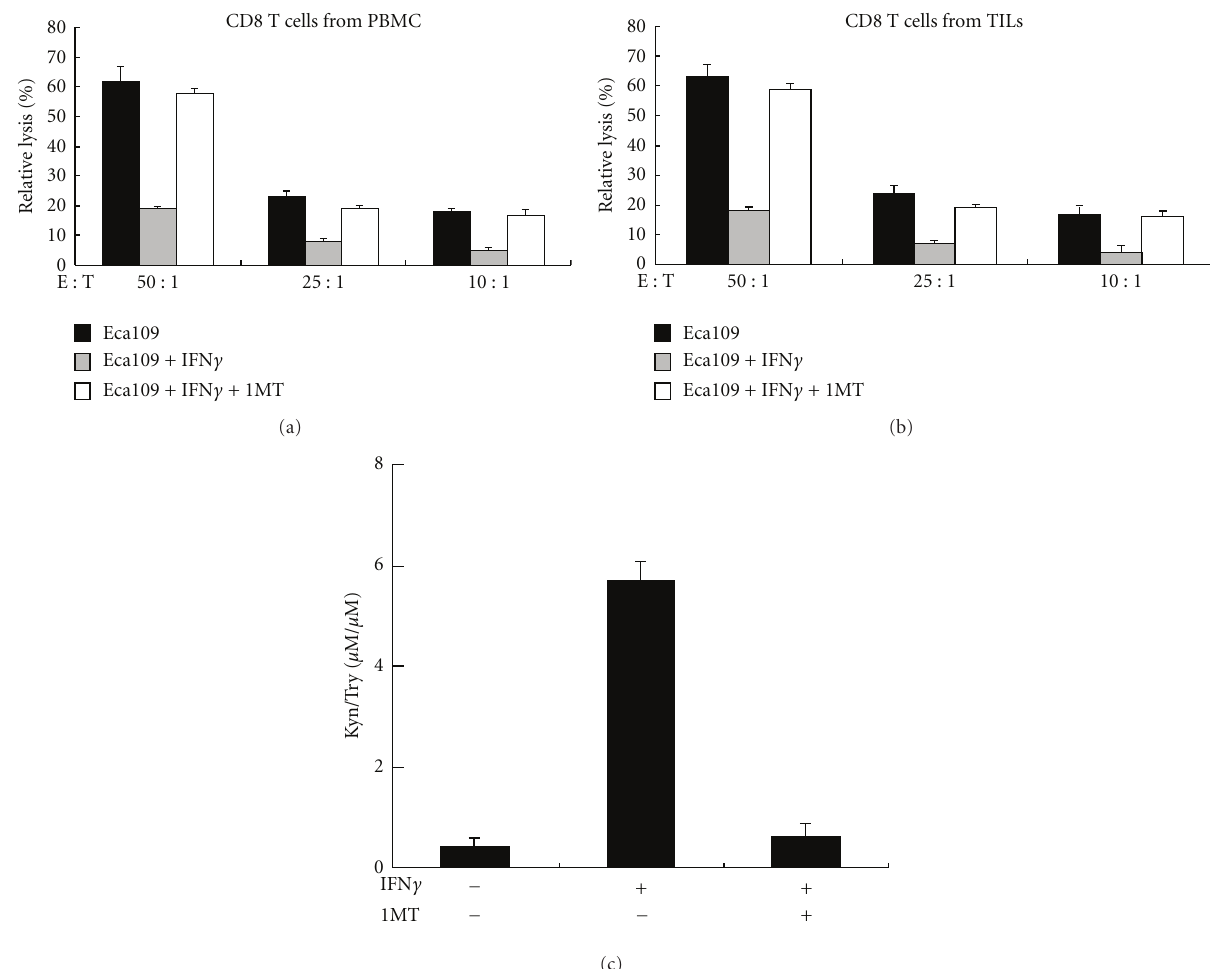
Figure 6: Cytolytic activity of CD8 + T cells from both PBMCs and TILs was impaired by incubation with media created by IDO-positive Eca109 cells. Activated CD8 + T cells from both PBMCs (a) and TILs (b) were cultured with CM from Eca109 cells treated with or without 50-U/mL IFN γ and/or 100- μ M 1MT for 24 hr, and cytolytic activity against Eca109 cells was evaluated using a standard LDH release assay. The E/T ratios are indicated. (c) Eca109 cells were treated with or without 50-U/mL IFN γ and/or 100- μ M 1 MT for 24hr. The Eca109 cell supernatants were analyzed for Kyn/Try production by HPLC. Columns, mean of three independent experiments. Bars, SD. ∗ P < 0.05 compared with CD8 + T cells cultured in conditioned media derived from non-IFN γ -treated Eca109